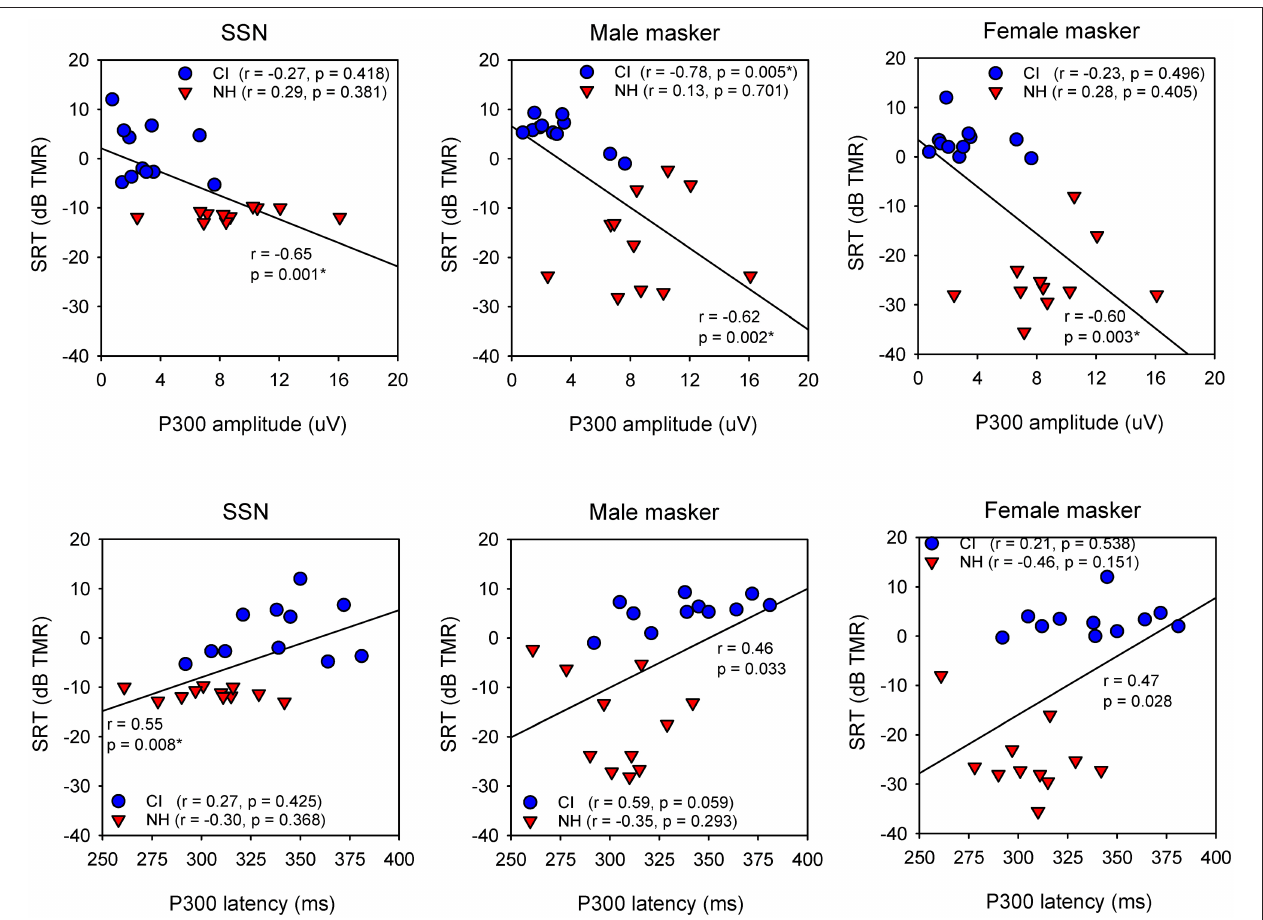
FIGURE 3 | (Top) Scatter plots of SRTs with SSN (left) or with a competing male (middle) or female talker (right) as a function of P300 amplitude, for the NH (red triangles) and CI listeners (blue circles). The diagonal line shows the linear regression across all data; the correlation coefficient and p value are shown near the line. Correlation coefficients and p values are shown for the CI data and NH data in the legend. Significant relationships after Bonferroni correction for multiple comparisons are indicated by asterisks. (Bottom) Same as top, but for SRTs as a function of P300